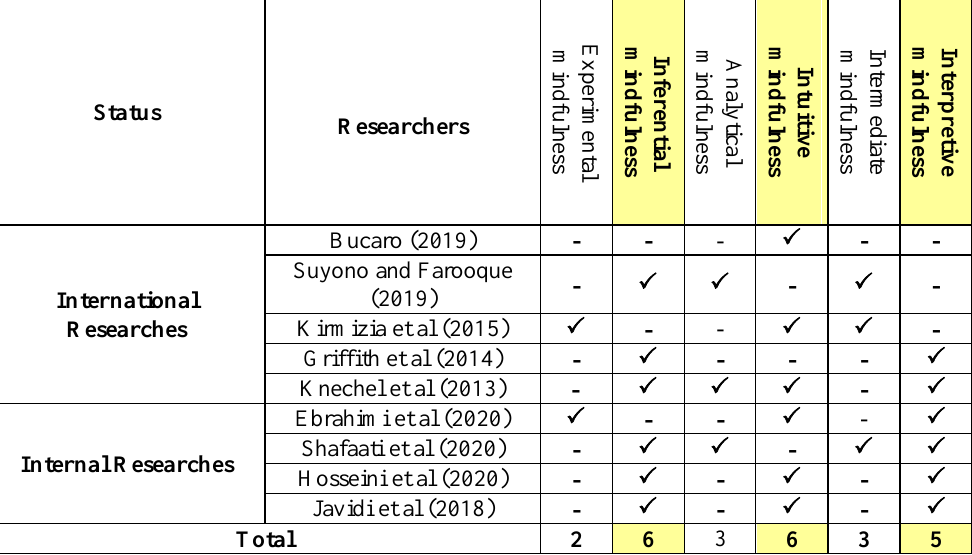
Table 5. The process of determining the main components of research